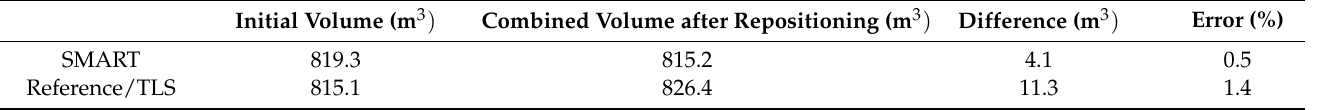
Table 9. SMART and TLS volume estimates for the left pile before/after